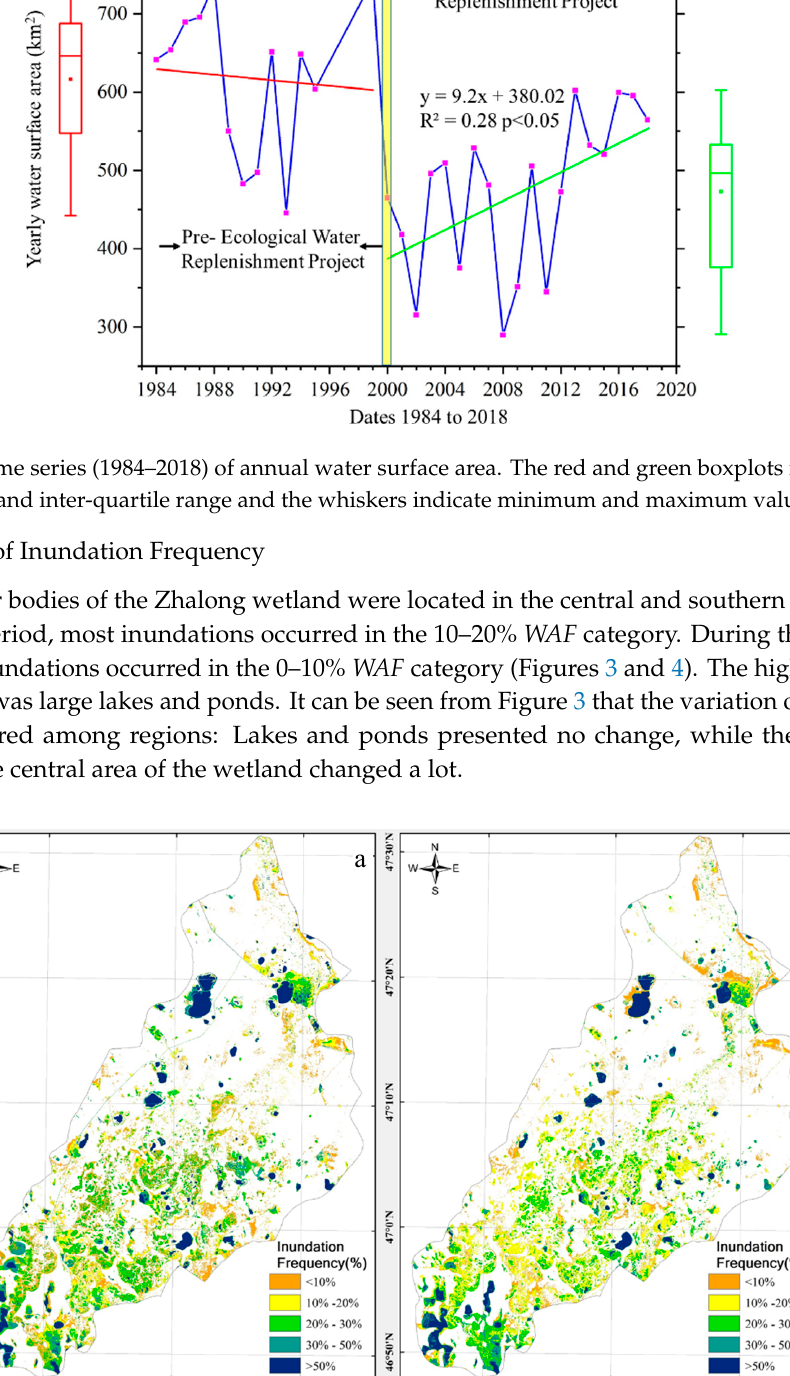
Figure 3. Spatial distribution of variation of inundation frequency during the ( a ) pre- and ( b ) post-ecological water replenishment (EWR) periods.